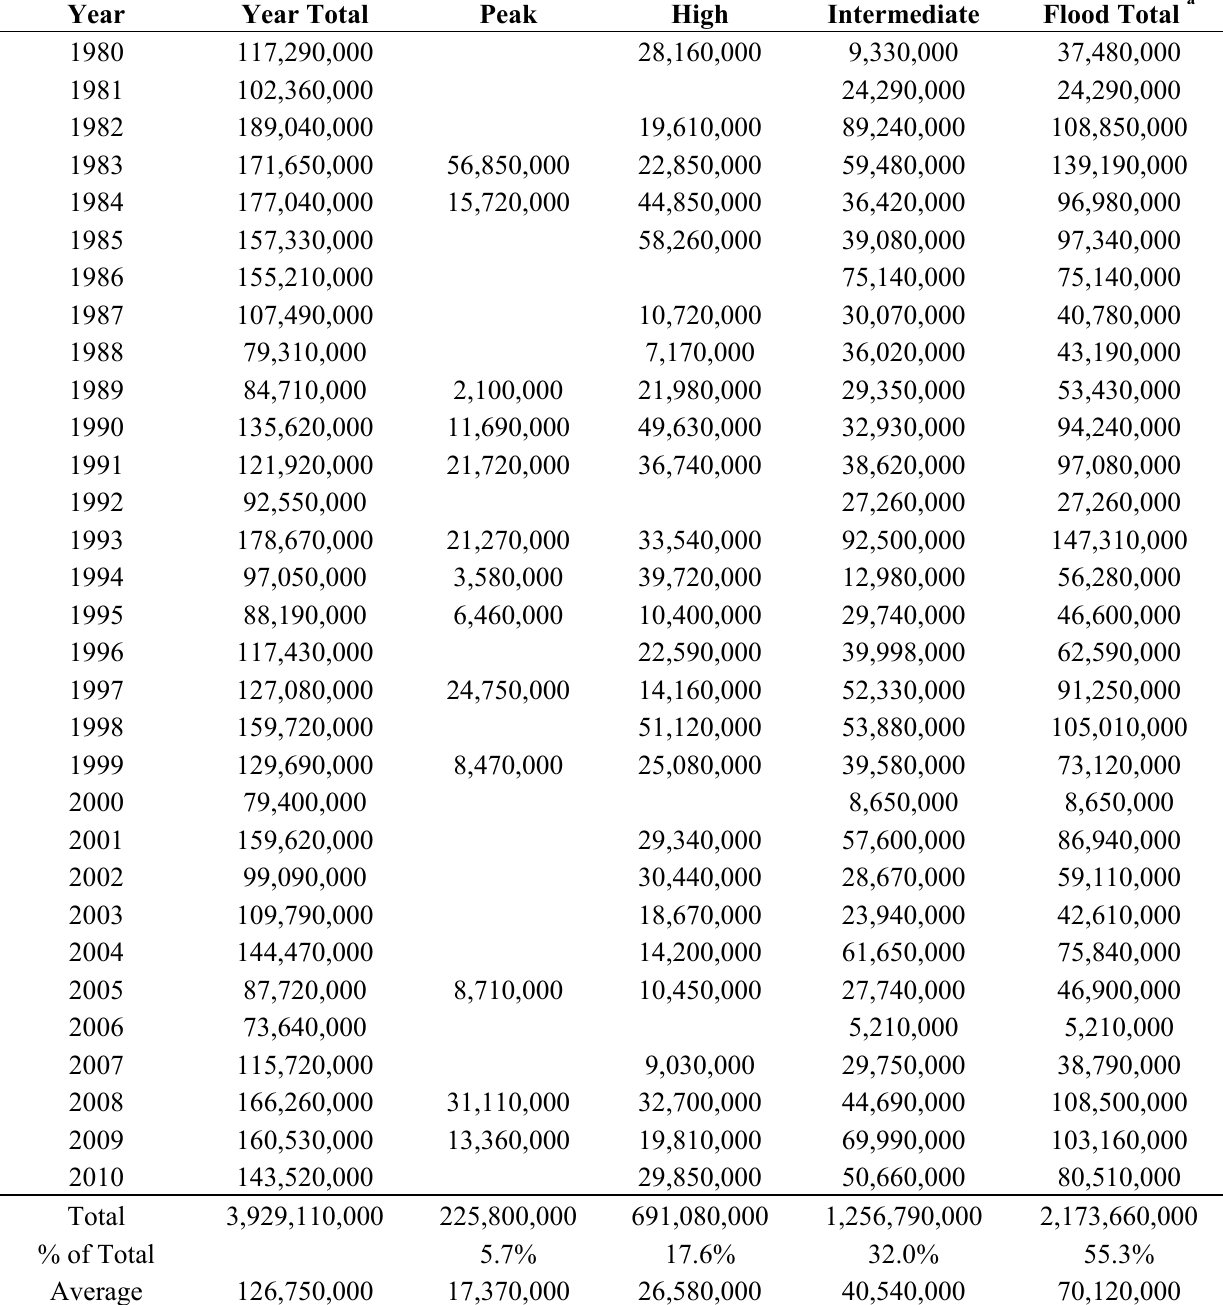
Table 2. Long-term annual (January–December) sediment yield (tonnes) for the Mississippi River at Tarbert Landing, MS and for flood stages, Peak, High, and